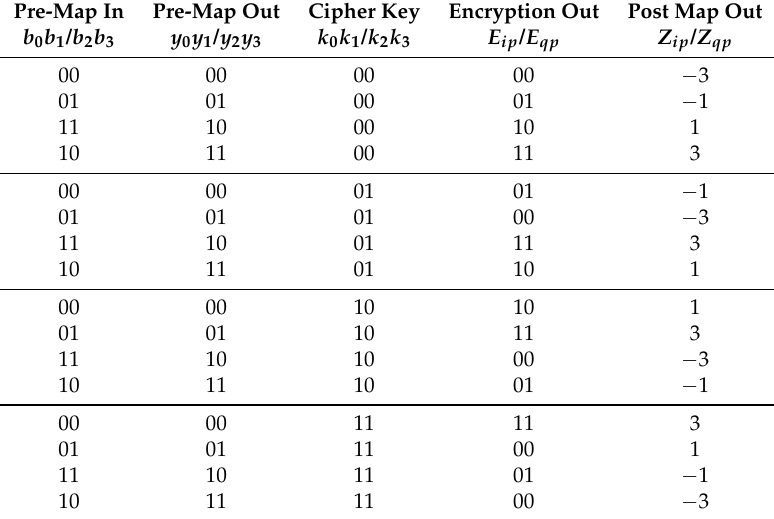
Table 1. The proposed JEM for 16-QAM